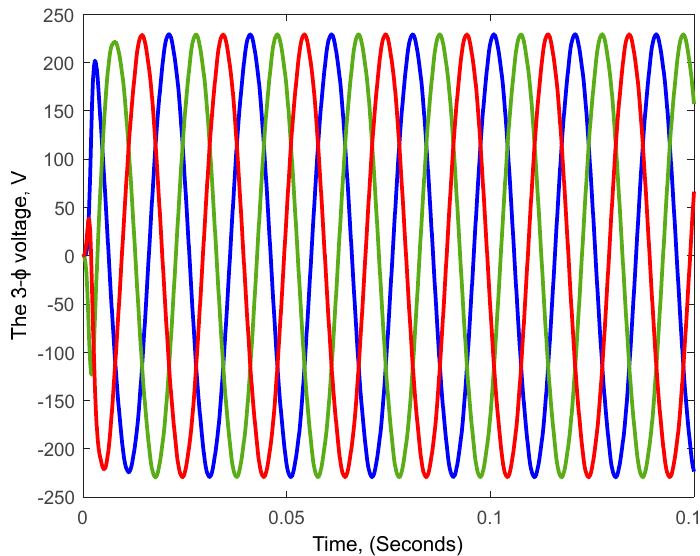
Figure 7. The three-phase output voltages.